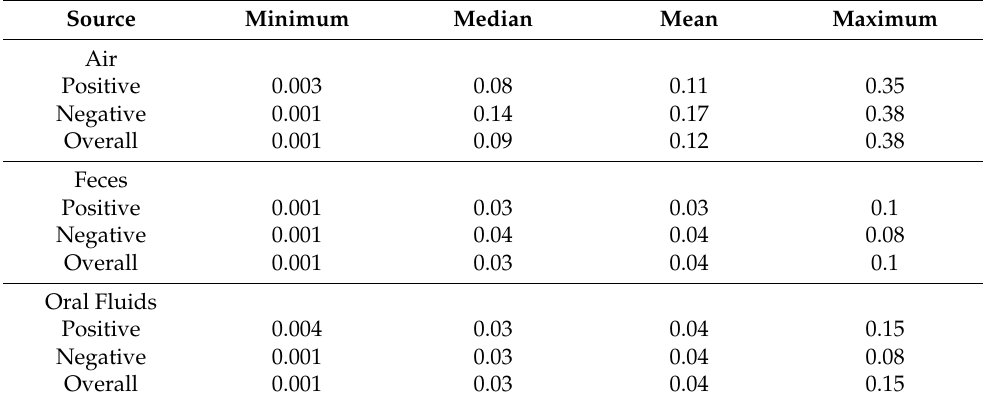
Table 4. Characteristics of the distribution of the proportions of tracheal fluid microbial communities potentially originating from fecal, air, or oral fluid sources.